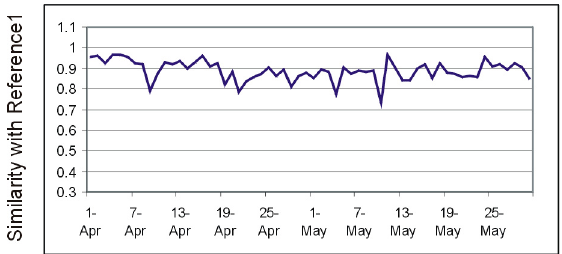
Figure 12. The similarity index for the night time (between midnight and 6 am) barely reflects the sensor change from April 18.